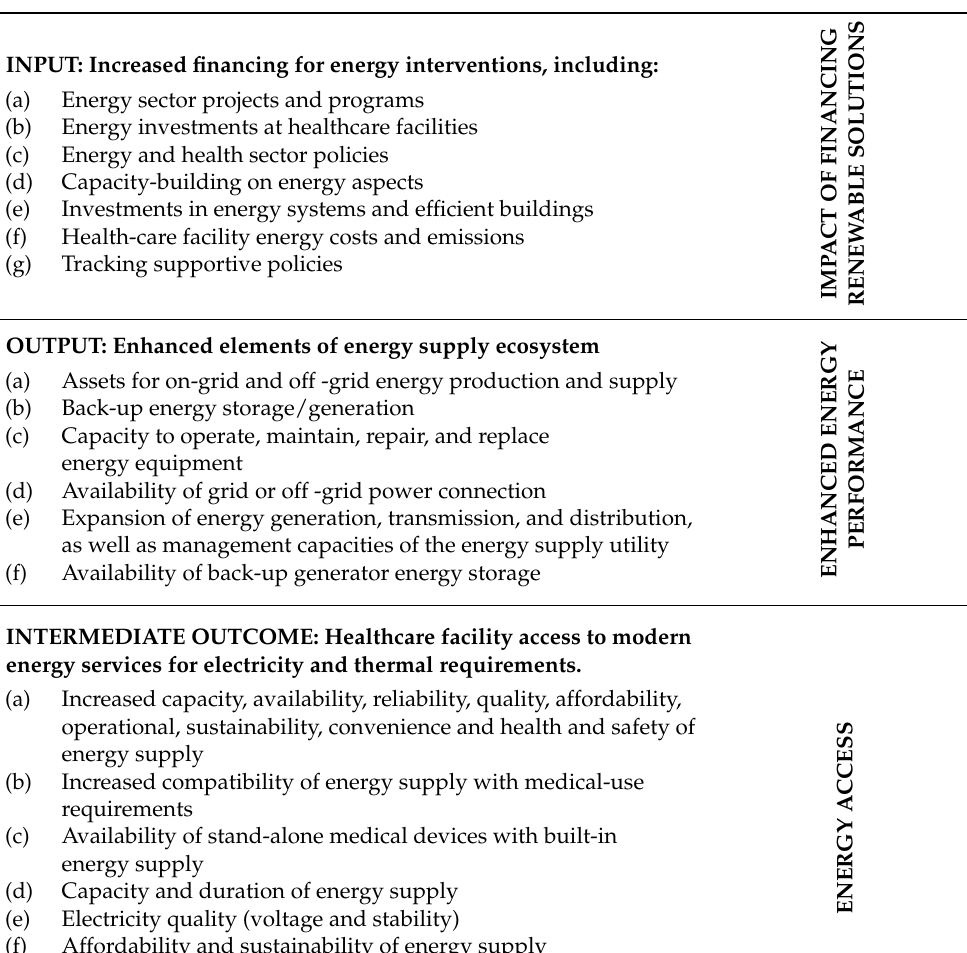
Table 1. Energy chain framework for Healthcare